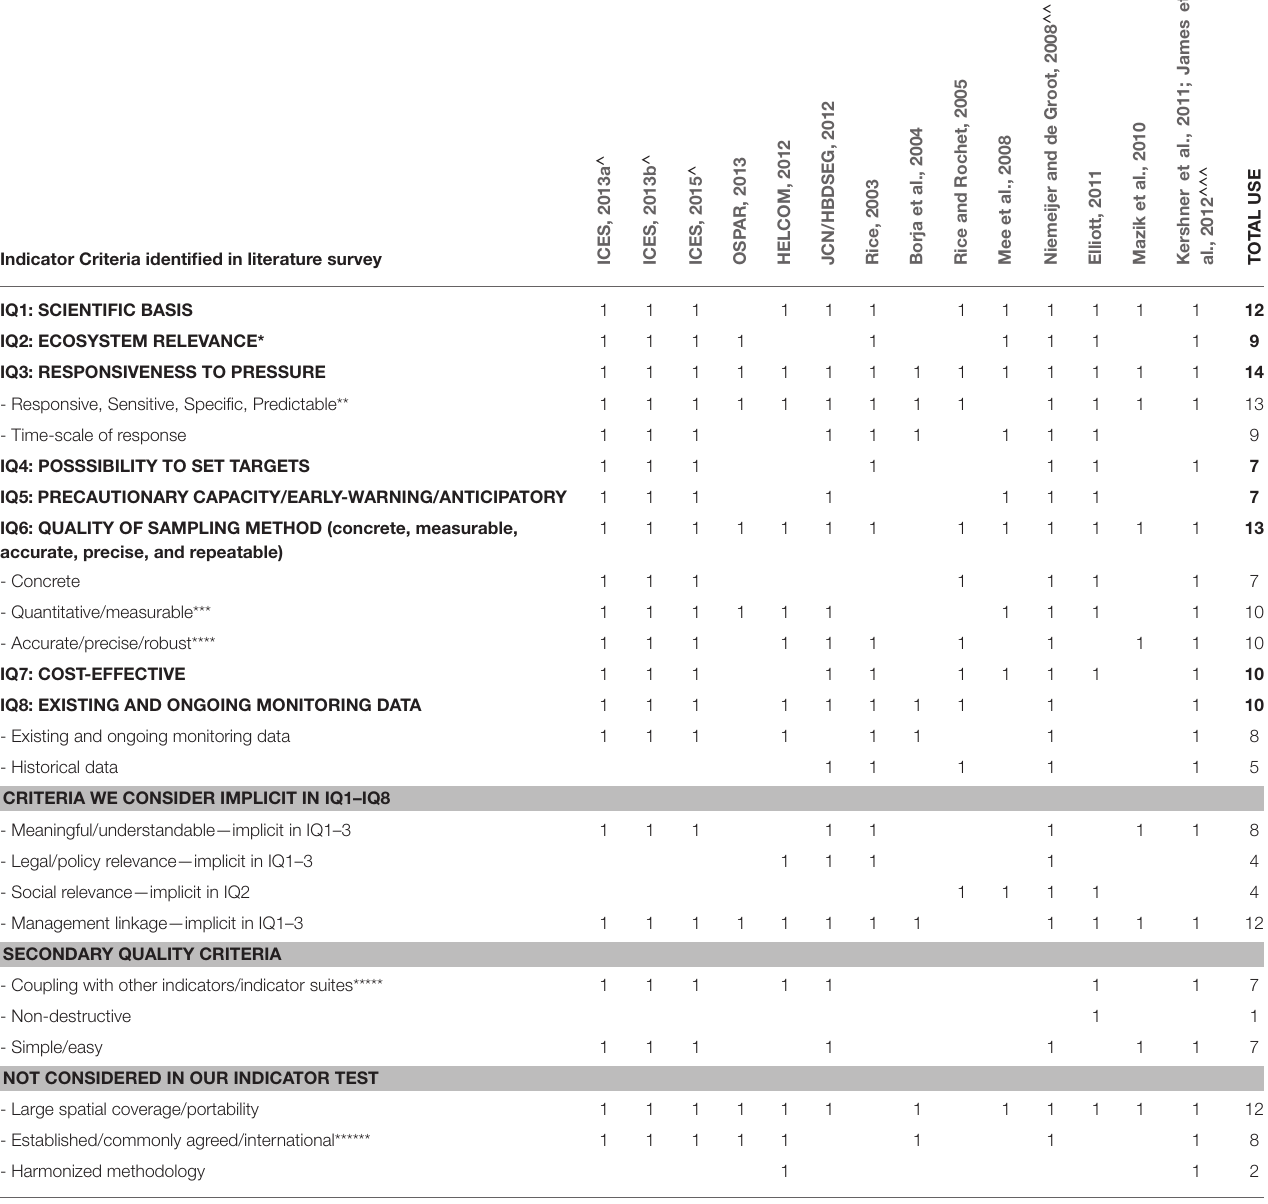
TABLE 1 | Literature survey of the use of indicator quality criteria